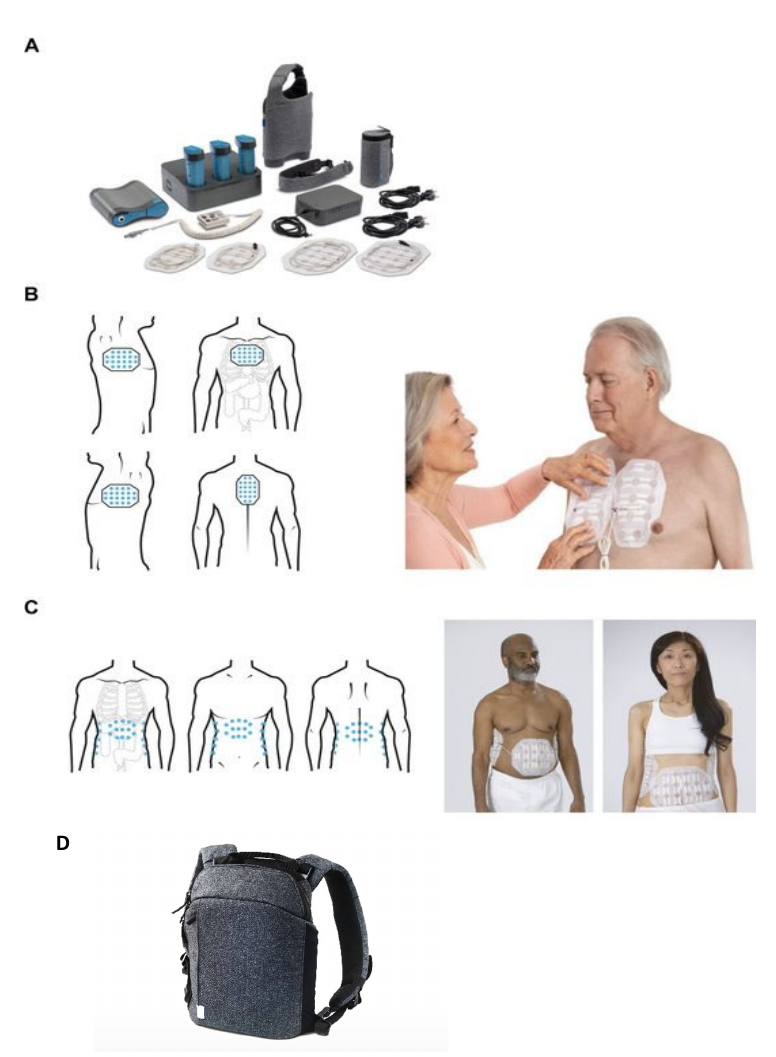
Figure 1. The Tumor Treating Fields (TTFields) medical device. ( A ) All components of the wearable medical device (NovoTTF ‐ 200T) that generates TTFields; example array layout* for ( B ) the torso and ( C ) the abdomen; ( D ) image of device within wearable backpack. Reused with permission from © 2023 Novocure GmbH ‐ all rights reserved. The models depicted here are actors and not patients. *The exact location of the array placement is determined during treatment planning, based on tumor location.